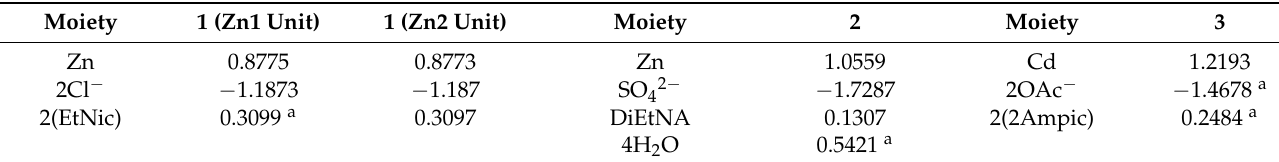
Table 9. Charge analysis in complexes 1 , 2 , and 3